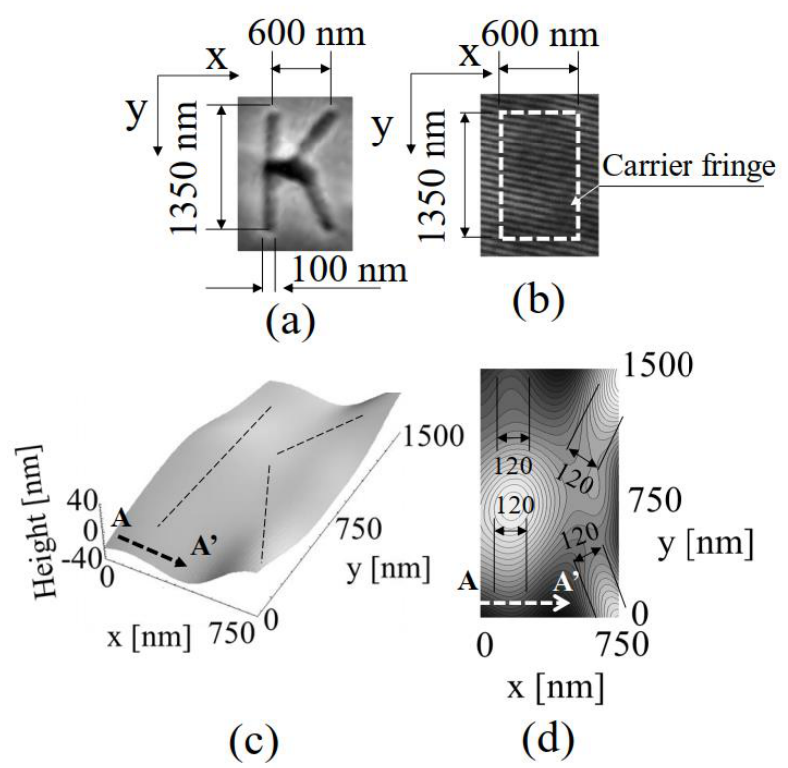
Figure 13. Measured result of alphabet character “K” beyond diffraction limit. ( a ) SEM image of the object; ( b ) Speckle pattern; ( c ) Measured result of shape; ( d ) Contour map of measured shape.